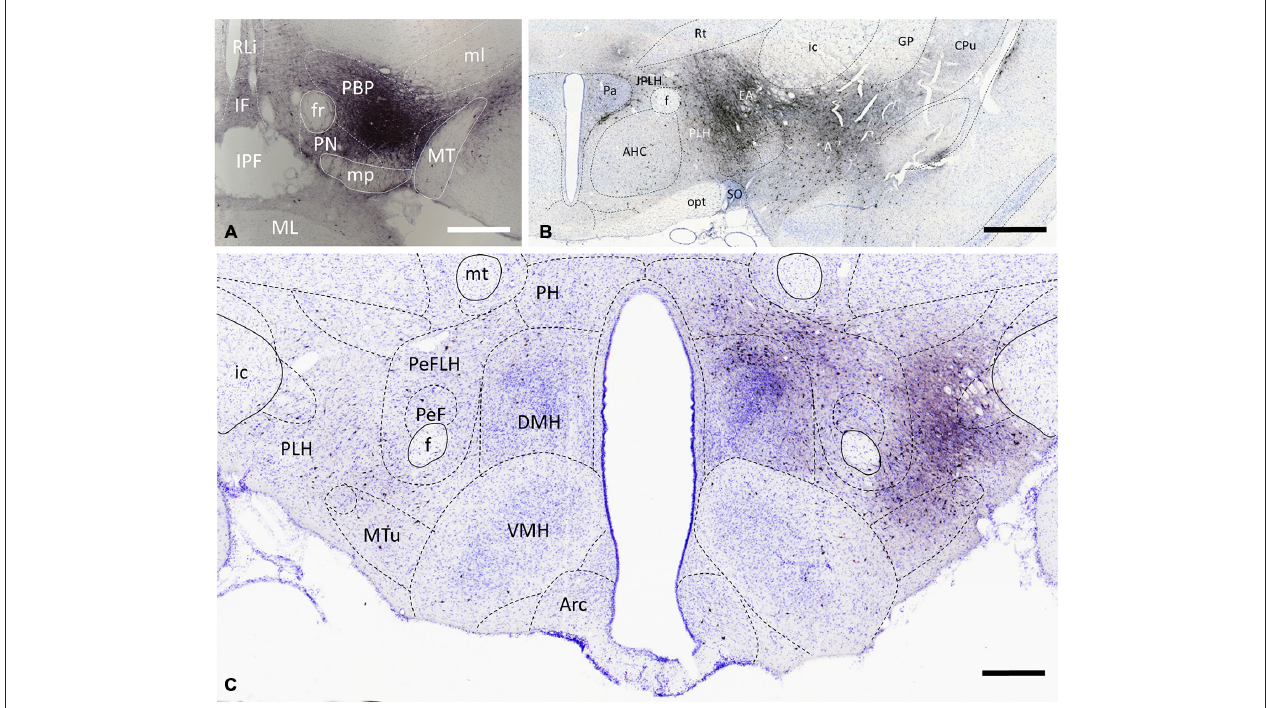
FIGURE 2 | Distribution of VTA-projecting neurons in the rat brain visualized by immunohistochemical detection of the retrograde tract tracer, cholera toxin B subunit (CTB). A representative CTB deposition (Case #2141) which is restricted to the parabrachial pigmented (PBP) nucleus of the VTA (at Bregma − 5.2) is shown in (A) . Retrogradely labeled cells are present bilaterally with significantly higher number on the ipsilateral side, as shown in the area of the paraventricular (B) and dorsomedial (C) nuclei. CTB-immunoreactive cells are in the amygdala (A) and extended amygdala (EA) complexes, as well as in lateral, and medial hypothalamic areas. Boundaries of brain regions (dashed lines) correspond to those delineated in the rat brain atlas [75]. Sections were counterstained with Toluidine blue. Scale bars: 1000 µ m for (A,B) , and 500 µ m for (C)